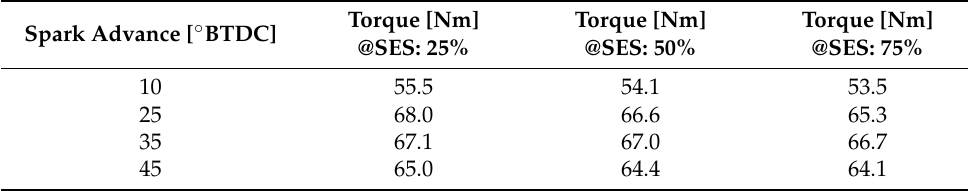
Table 7. Torque [Nm] values for different spark advances and syngas energy share.